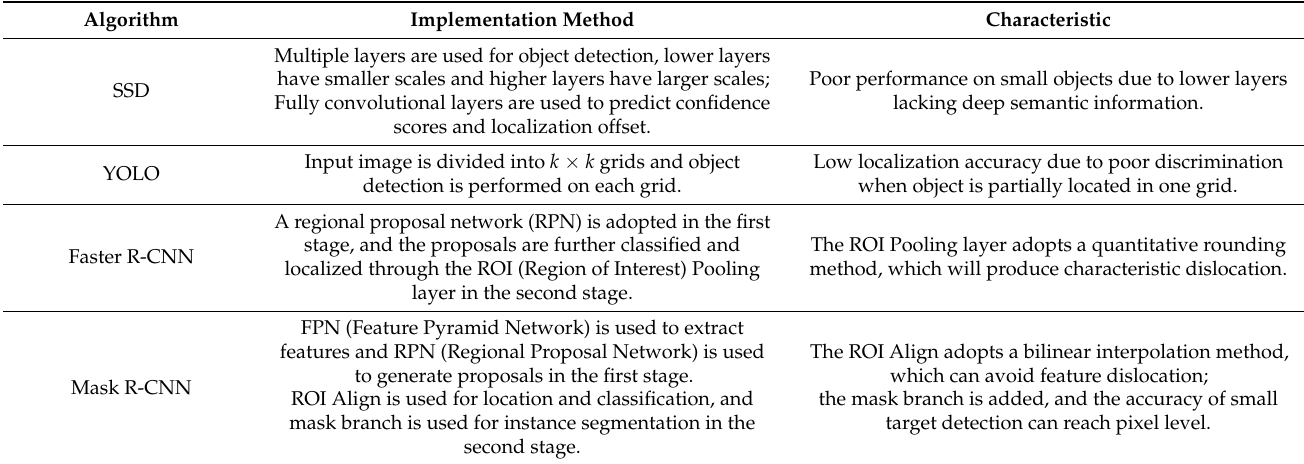
Table 1. Comparison of different target recognition algorithms.